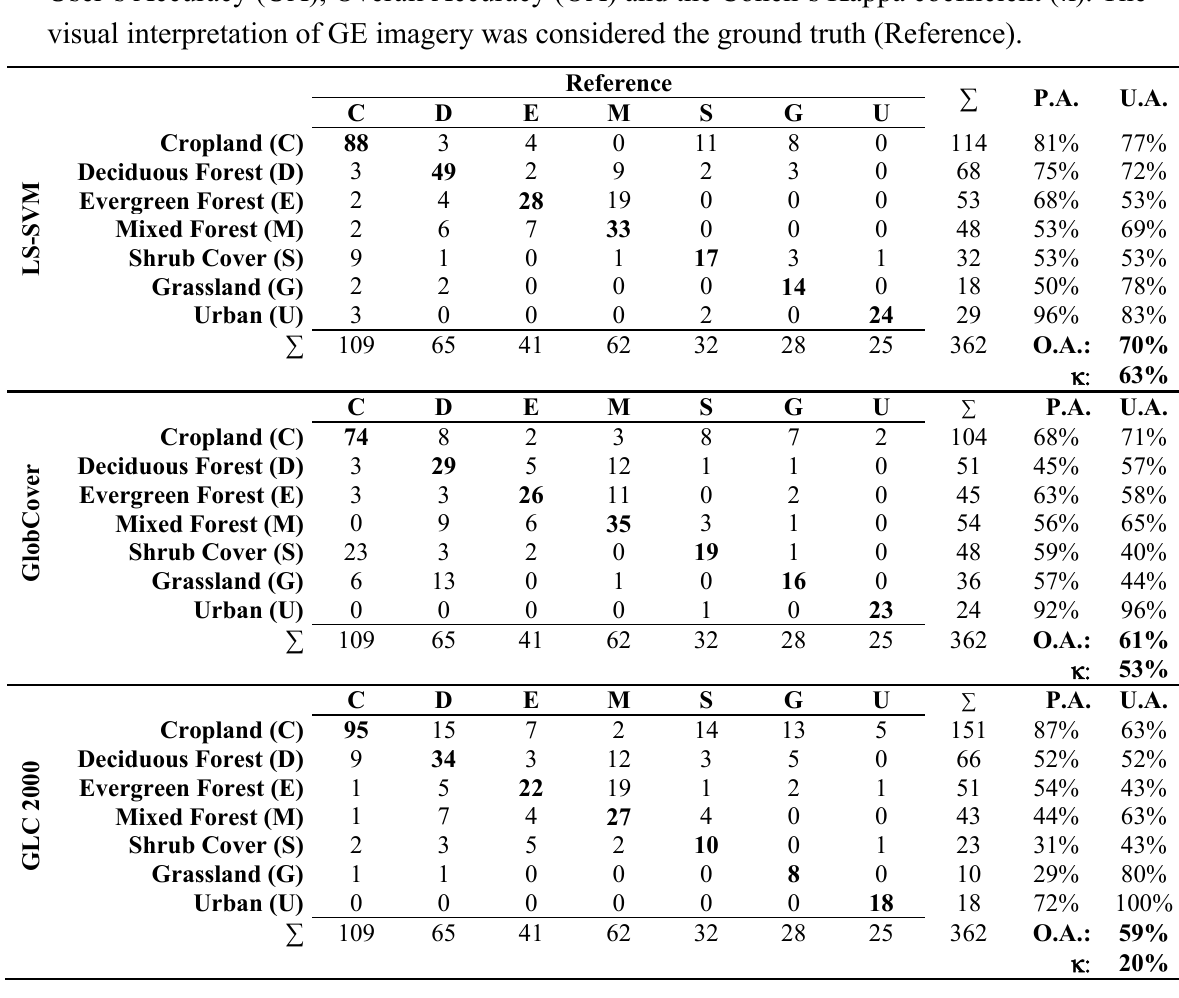
= 362). The error tot